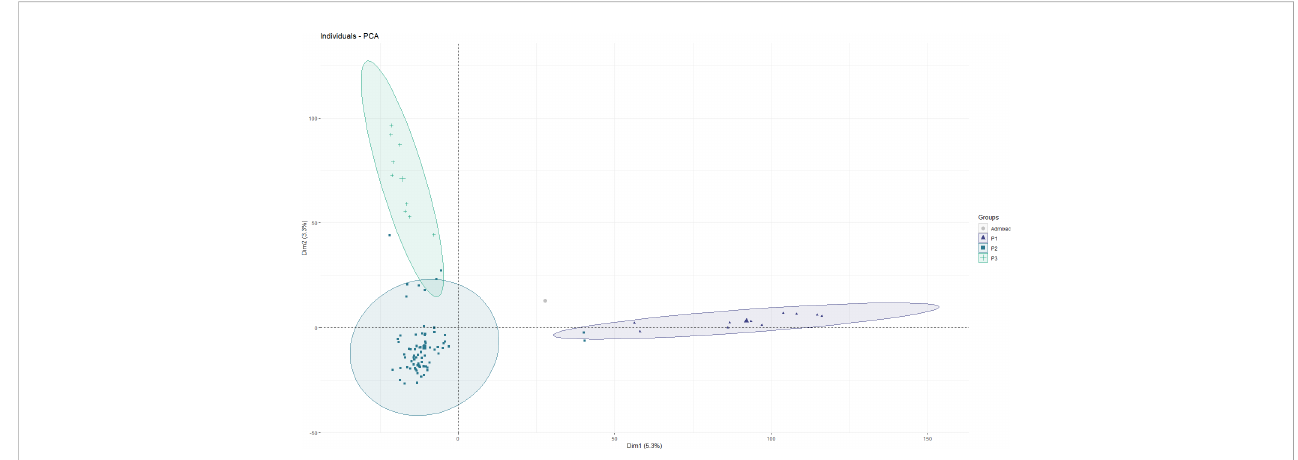
FIGURE 3 Principal component analysis (PCA) of the 93 faba bean accessions. Each dot represents an accession. The horizontal and vertical coordinates represent the fi rst two principal components of analysis (PC1 and PC2), accounting for 5.3% and 3.3% of the total variation,